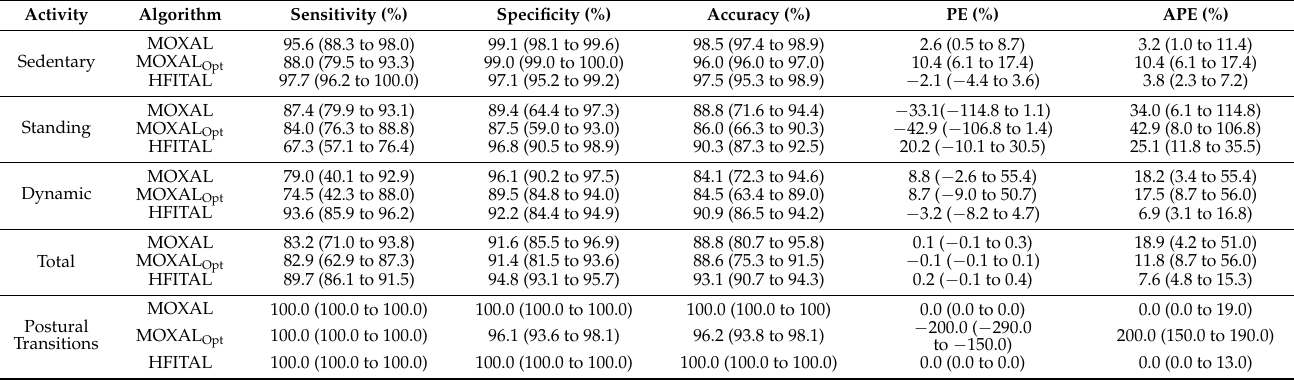
Table 3. Median values (Q1 to Q3) of the performance metrics (%, sensitivity, specificity, accuracy, PE, and APE) of the classification of activities by MOXAL, MOXAL Opt , and HFITAL within the optimization group ( n = 22).